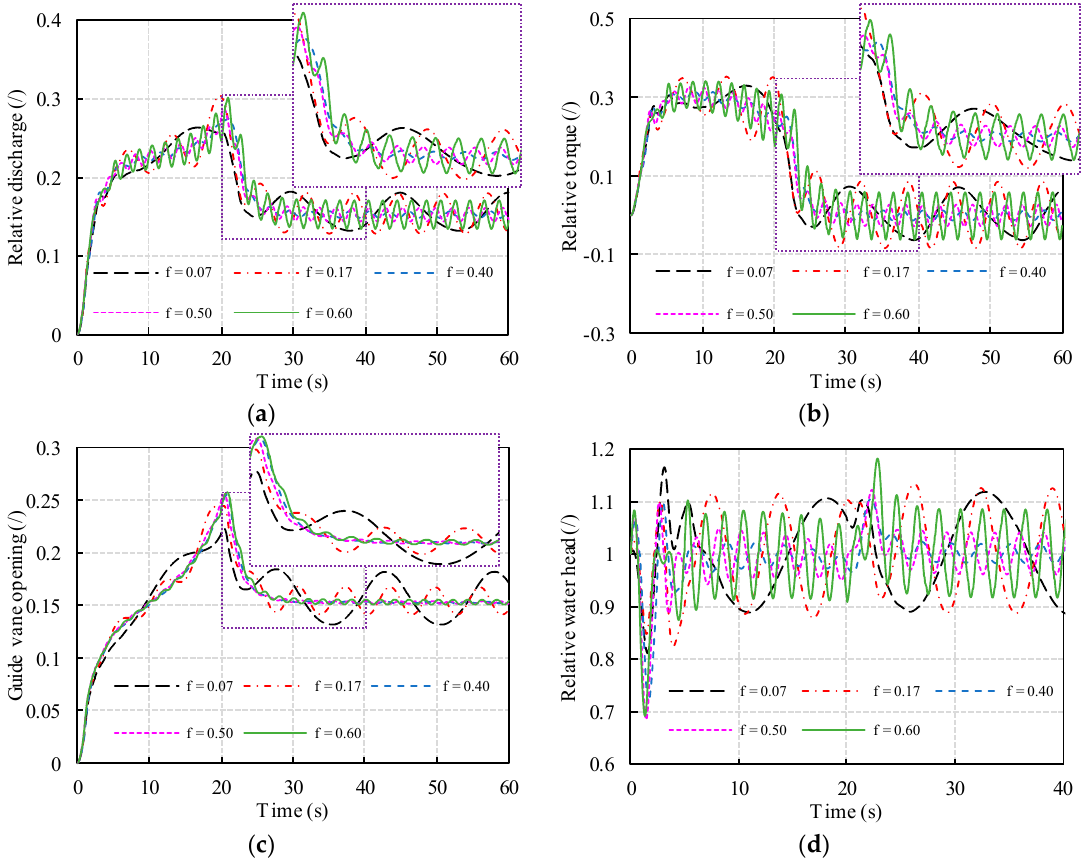
Figure 10. Comparison of closed-loop start-up characteristics of different tail water fluctuation frequencies under a fixed fluctuation amplitude: ( a ) Time history of discharge; ( b ) time history of torque; ( c ) time history of guide vane opening; and ( d ) time history of water head.